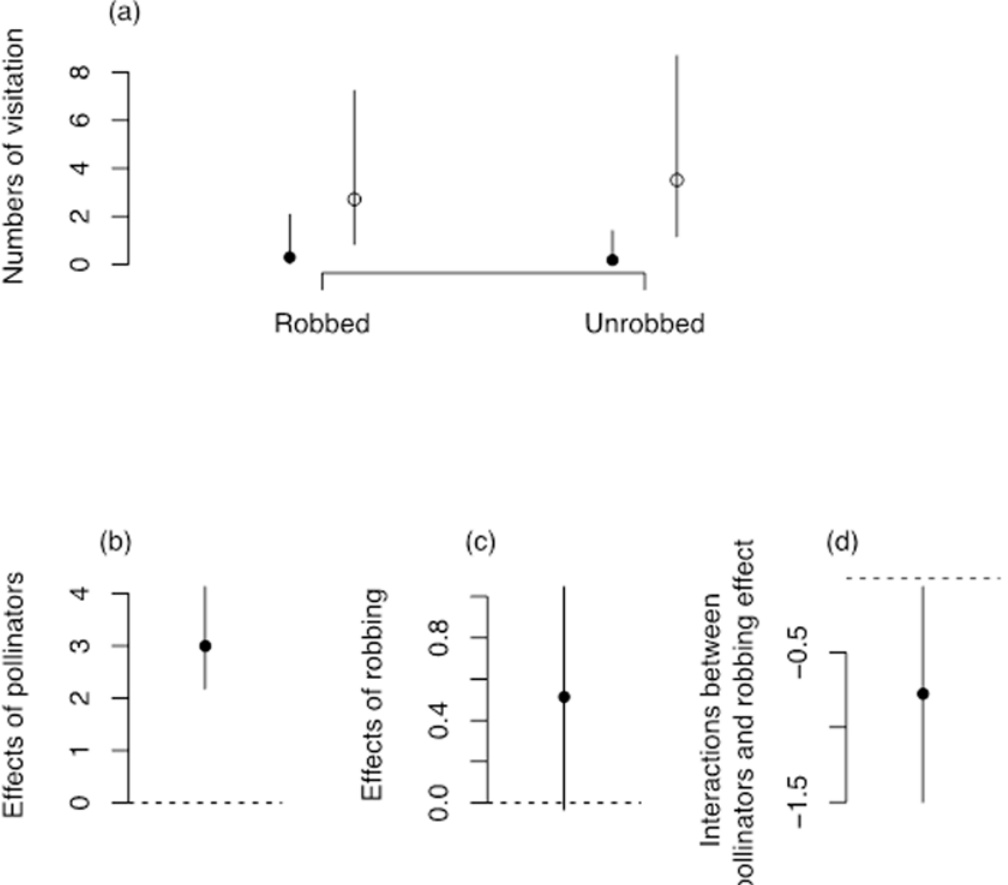
Fig 6. (A) Posterior means of numbers of Bombus eximius (open circles) and Apis cerana (closed circles) between robbed and unrobbed plots. (B) Effects of pollinators indicates the effect of Apis cerana was set to zero. (C) Effects of robbing. (D) Interactions of robbing and pollinators, and their effects. Bars represent the 95% confidence interval of the posterior distribution in each